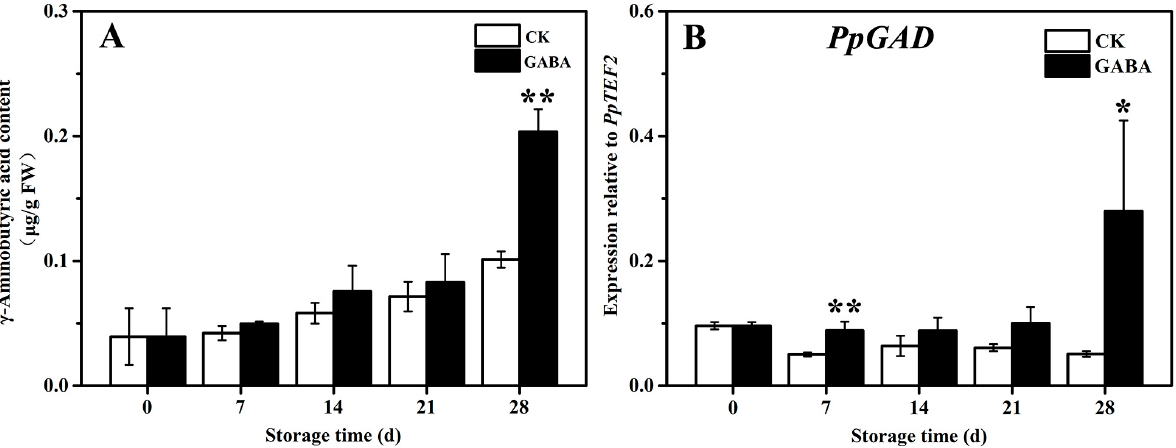
Figure 4. Change in ( A ) GABA content and ( B ) PpGAD expression in peach fruit induced by GABA. All data are expressed as means ± standard errors (SE). Asterisks (*) indicate significant differences between the GABA and CK groups. Unmatched Student’s t -test; (*) p < 0.05, (**) p < 0.01.